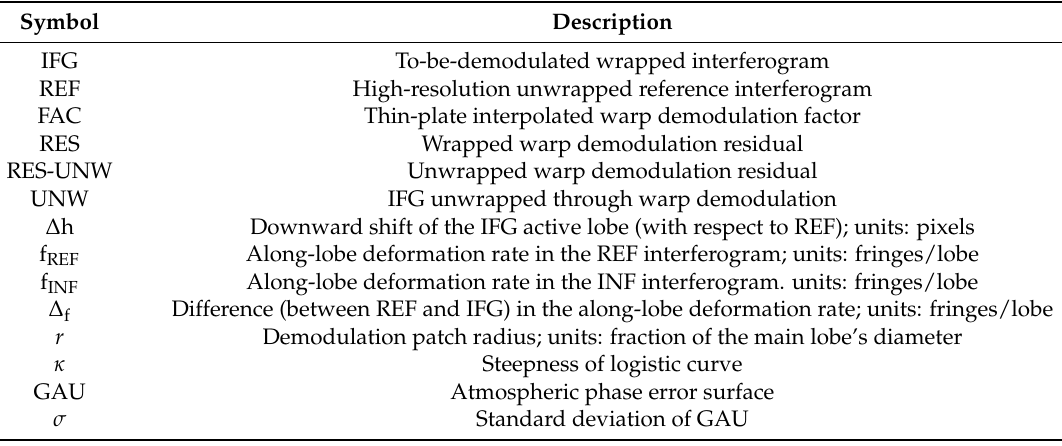
Table 2. List of parameters used in Section